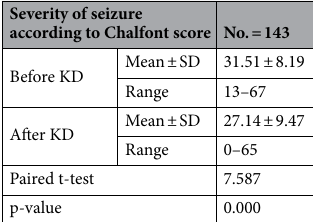
Table 2. Comparison of severity of seizure according to Chalfont score before and after KD.